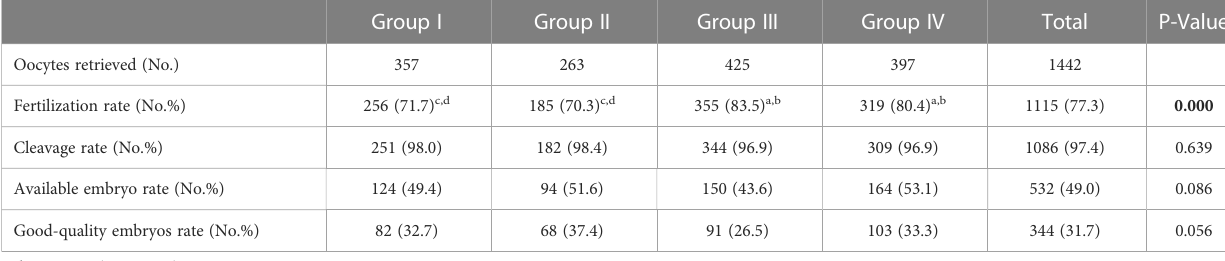
TABLE 2 Embryo quality assessment among 4 groups.